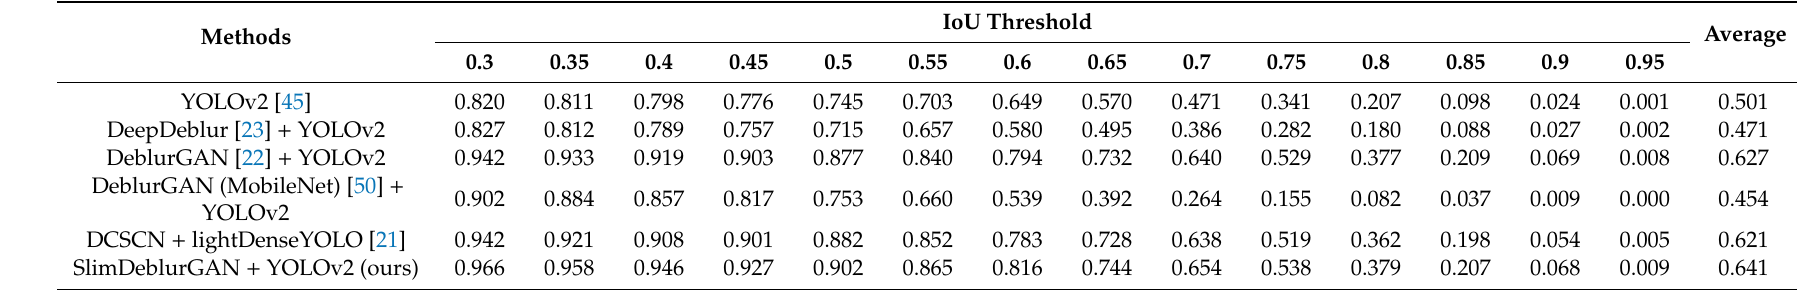
Table 10. Comparisons of recall on SMBD-DB1.